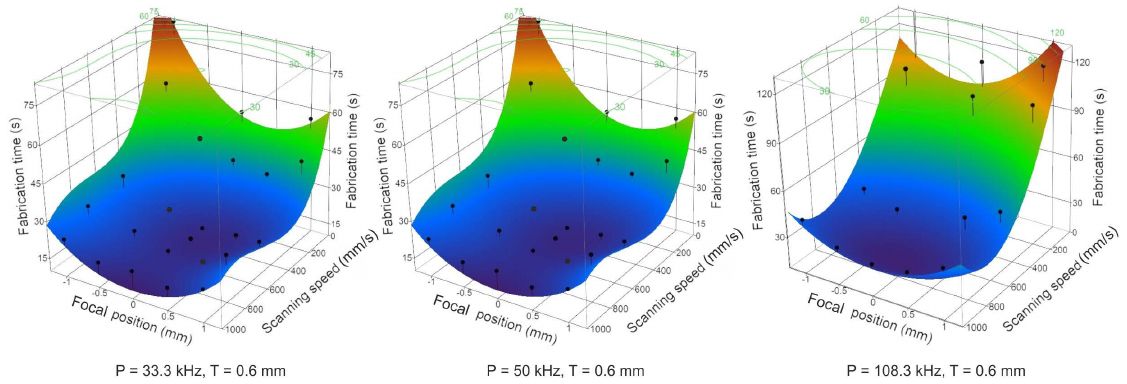
Figure 6. Focal position and scanning speed values vs. results (fabrication duration for cutting metals) graphs at different repetition rate settings. The black dots are the actually measured points and the surface is produced via the prediction expression.